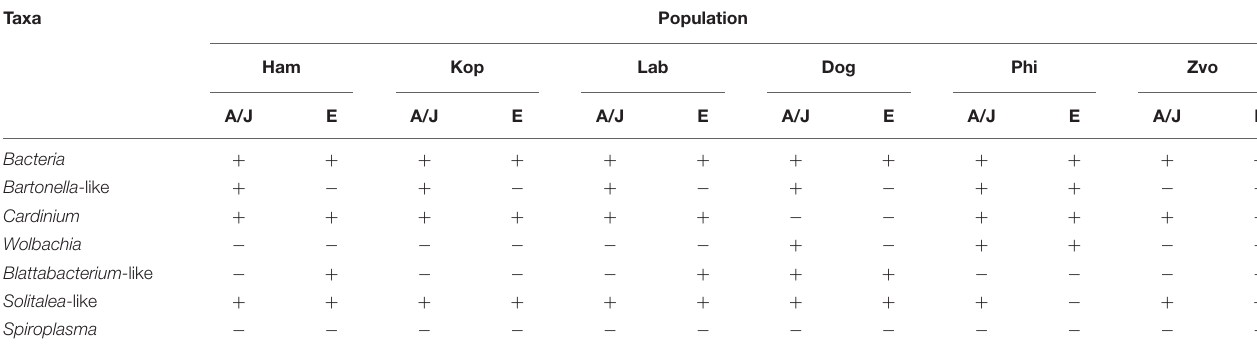
TABLE 3 | The presence or absence of amplicons of bacterial 16S rRNA generated with universal and taxon-specific primers in different populations of Tyrophagus putrescentiae .